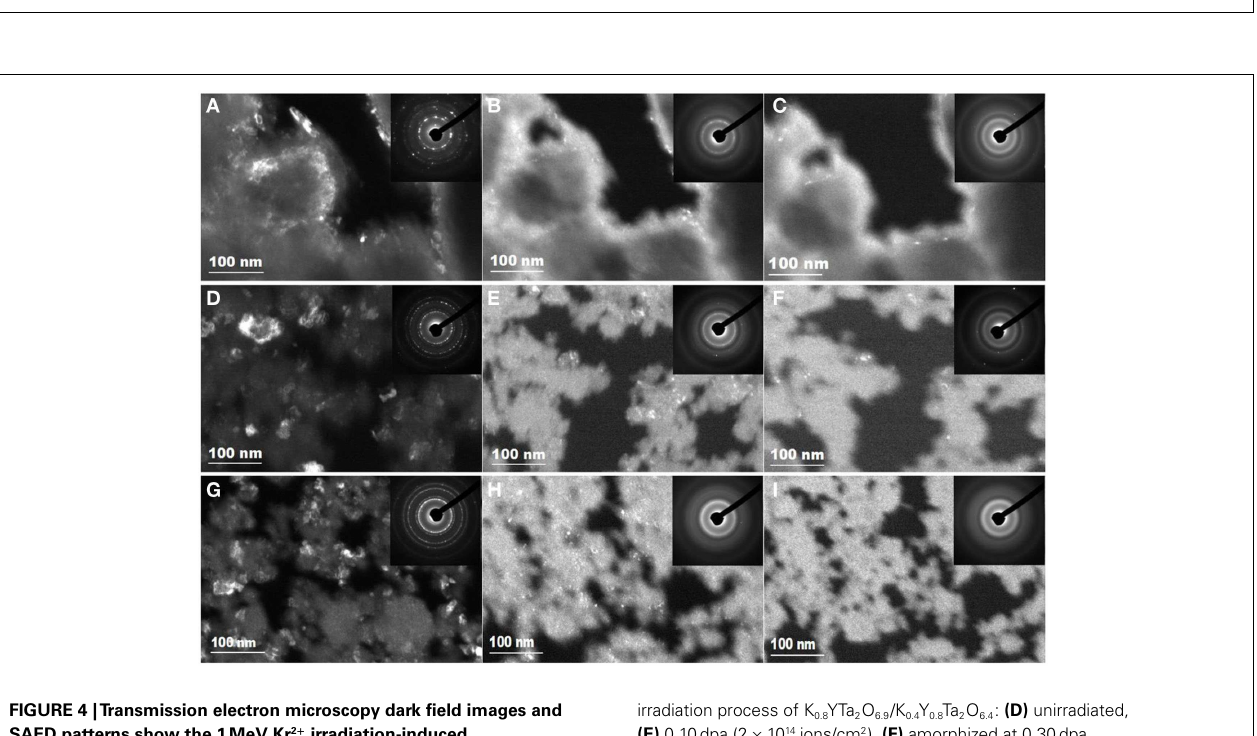
FIGURE 3 |Transmission electron microscopy dark field images and SAED patterns show the 1MeV Kr 2 + irradiation-induced amorphization process of the nano-sized tantalate pyrochlores at room temperature . Irradiation process of K 0.8 GdTa 2 O 6.9 : (A) unirradiated, (B) 0.05dpa (1 × 10 14 ions/cm 2 ), (C) amorphized at 0.12dpa